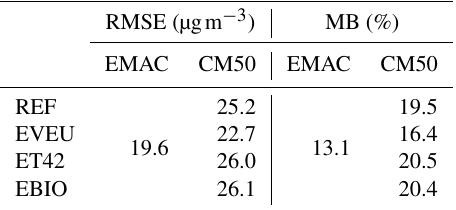
Table 3. Root-mean-square error (RMSE; in micrograms per cubic metre) and normalised mean bias error (MB; in percent) of O 3 for EMAC and CM50 in comparison with ground-level observations. Shown are the average values for June to August 2008. The values are calculated from monthly mean values. The model values are height corrected as discussed in detail by Mertens et al.